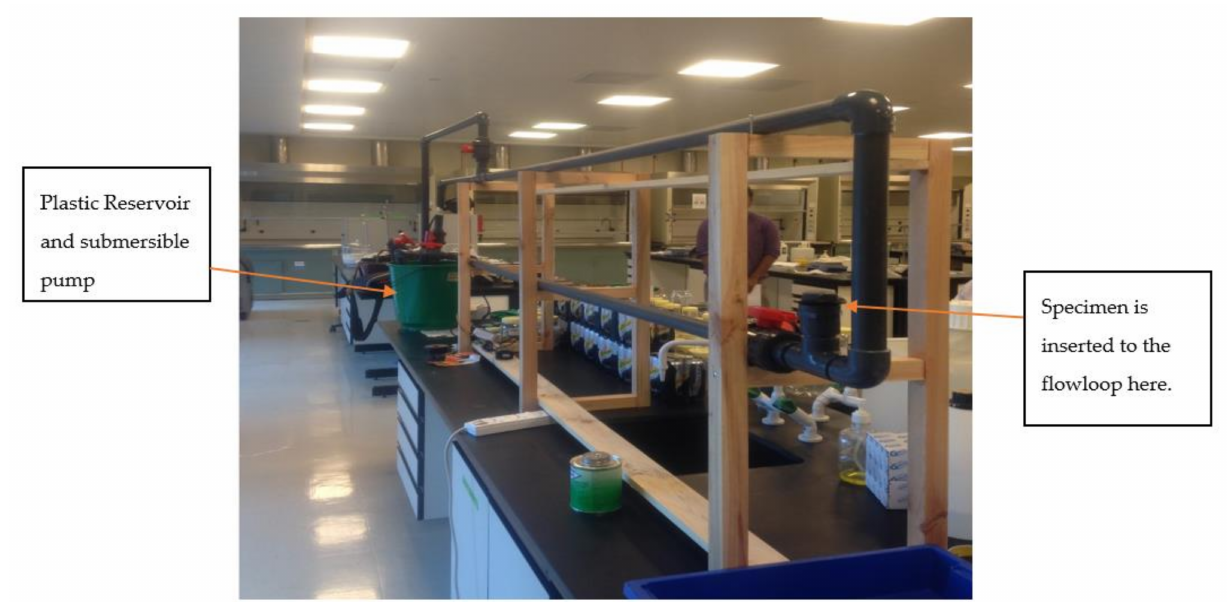
Figure 3. A layout of the experimental setup.